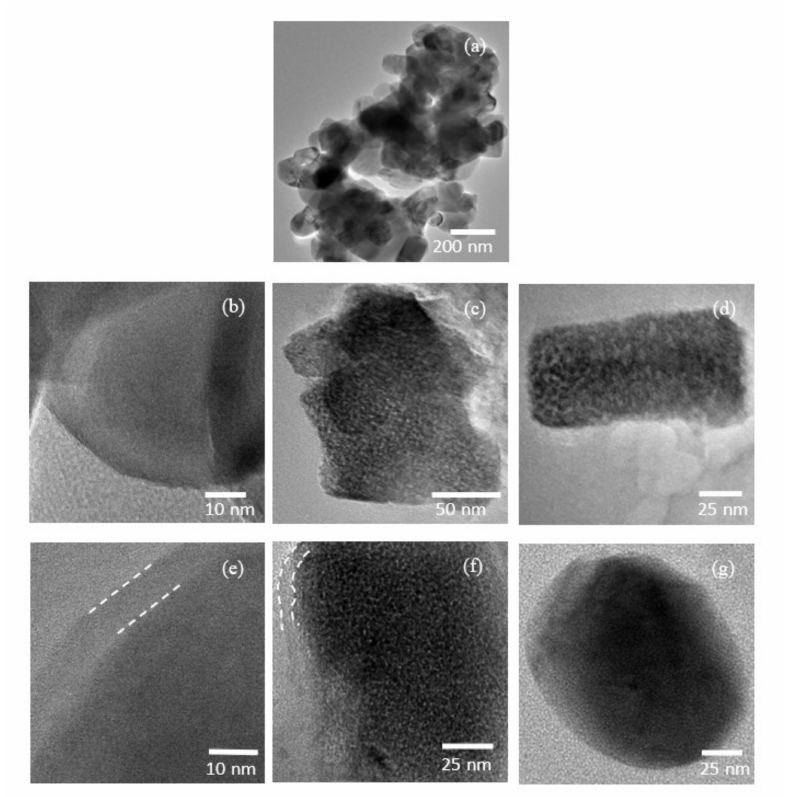
Figure 10. Transmission electron microscopy (TEM) images of ( a , b ) LR–Bare before cycle and ( c , d ) after 100 cycles; and ( e ) LR–Sp2.5 before cycle and ( f , g ) after 100